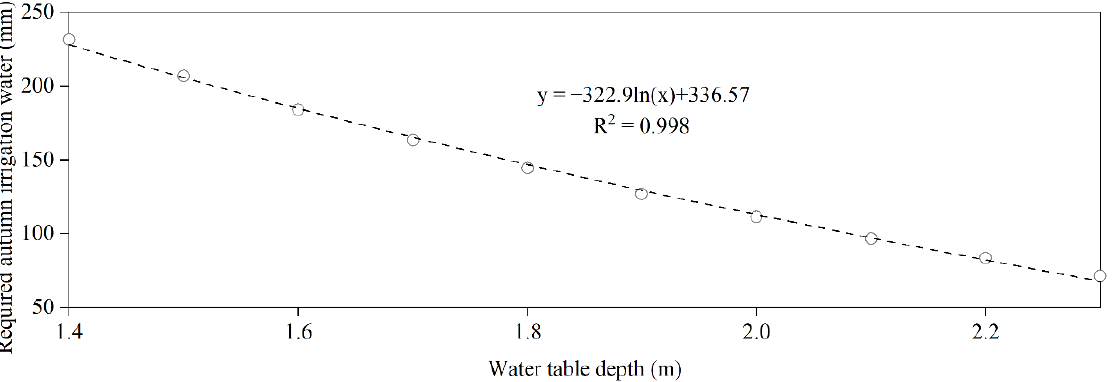
Figure 12. The relationship between water table depths and the required autumn irrigation water to sustain root zone within a mild salinity level in the canal irrigation area.